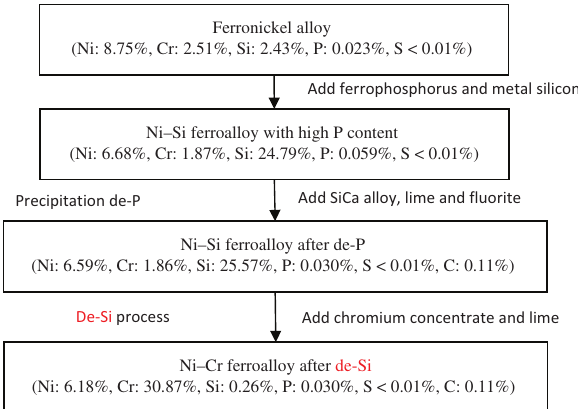
Figure 3: Pilot-scale experiment for the Ni – Cr ferroalloy production with electrosilicothermic